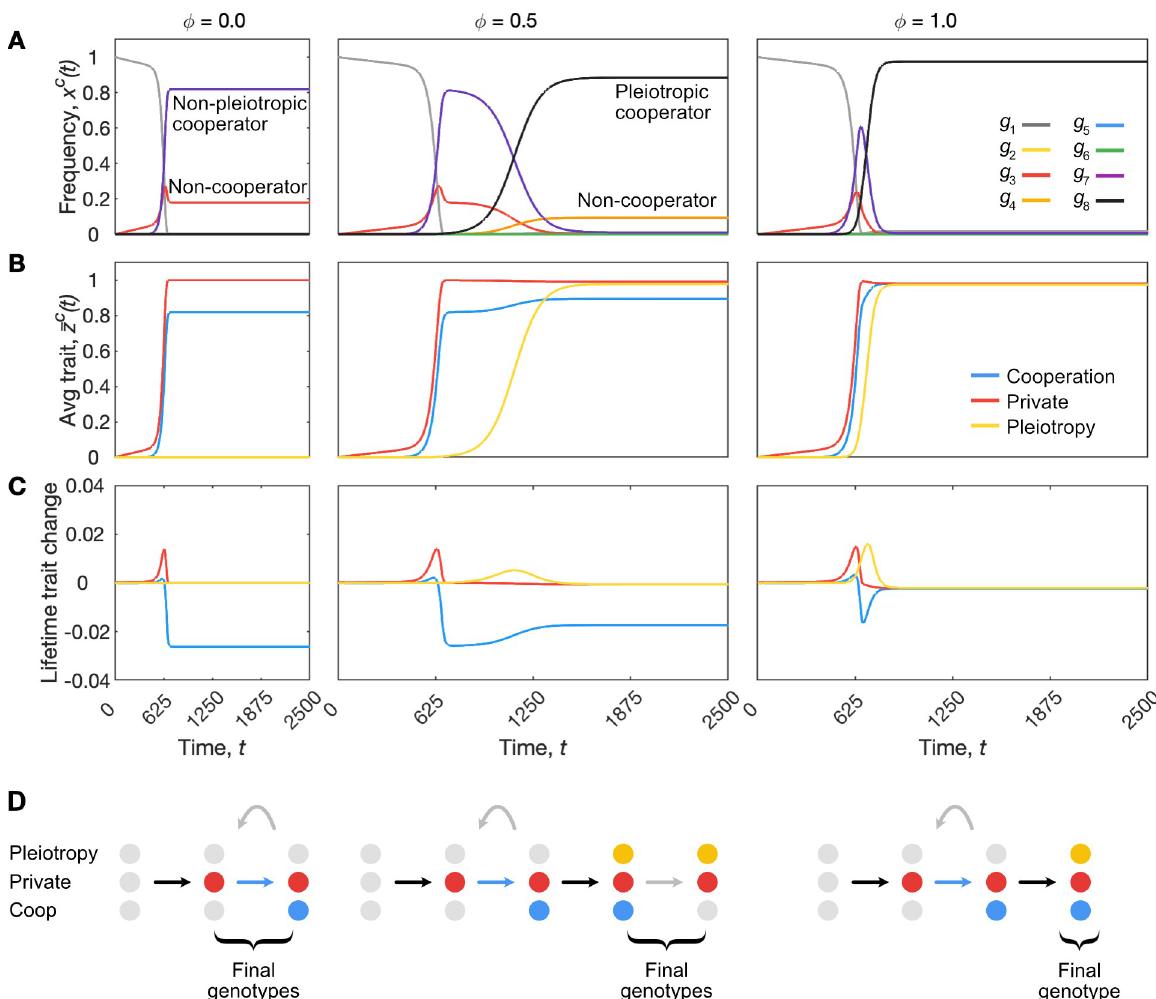
Fig 5. Long-term evolutionary dynamics of cooperation and pleiotropy. Dynamics are shown for the global population of cells over time, t , which encompasses many generations of cell groups. These dynamics encompass both within-group and between-group selection dynamics. We show 3 strengths of pleiotropy, ϕ , to capture 3 scenarios where stronger pleiotropy is associated with more rapid and complete evolution of both pleiotropy and cooperation. (A) Changes in global genotype relative frequencies, x c ( t ). (B) Changes in the global average levels of cooperation, private trait expression, and pleiotropy, z c ð t Þ . (C) Average change in traits over a group lifetime, measured as the difference between the average trait values among groups aged y to those expected from their founding cell at birth. (D) Order in which genotypes invade in the global population, where a blue arrow indicates a gain of cooperation (via between-group selection), a grey arrow indicates a loss of cooperation (via within-group selection) and a black arrow indicates no change in cooperation. Parameters: s c = s g = 0.95; K = 200; μ = 0.0001; ν = 0.01; λ = 20. The code required to generate this figure can be found at https://github.com/euler-mab/pleiotropy and https://zenodo.org/record/6367788#.